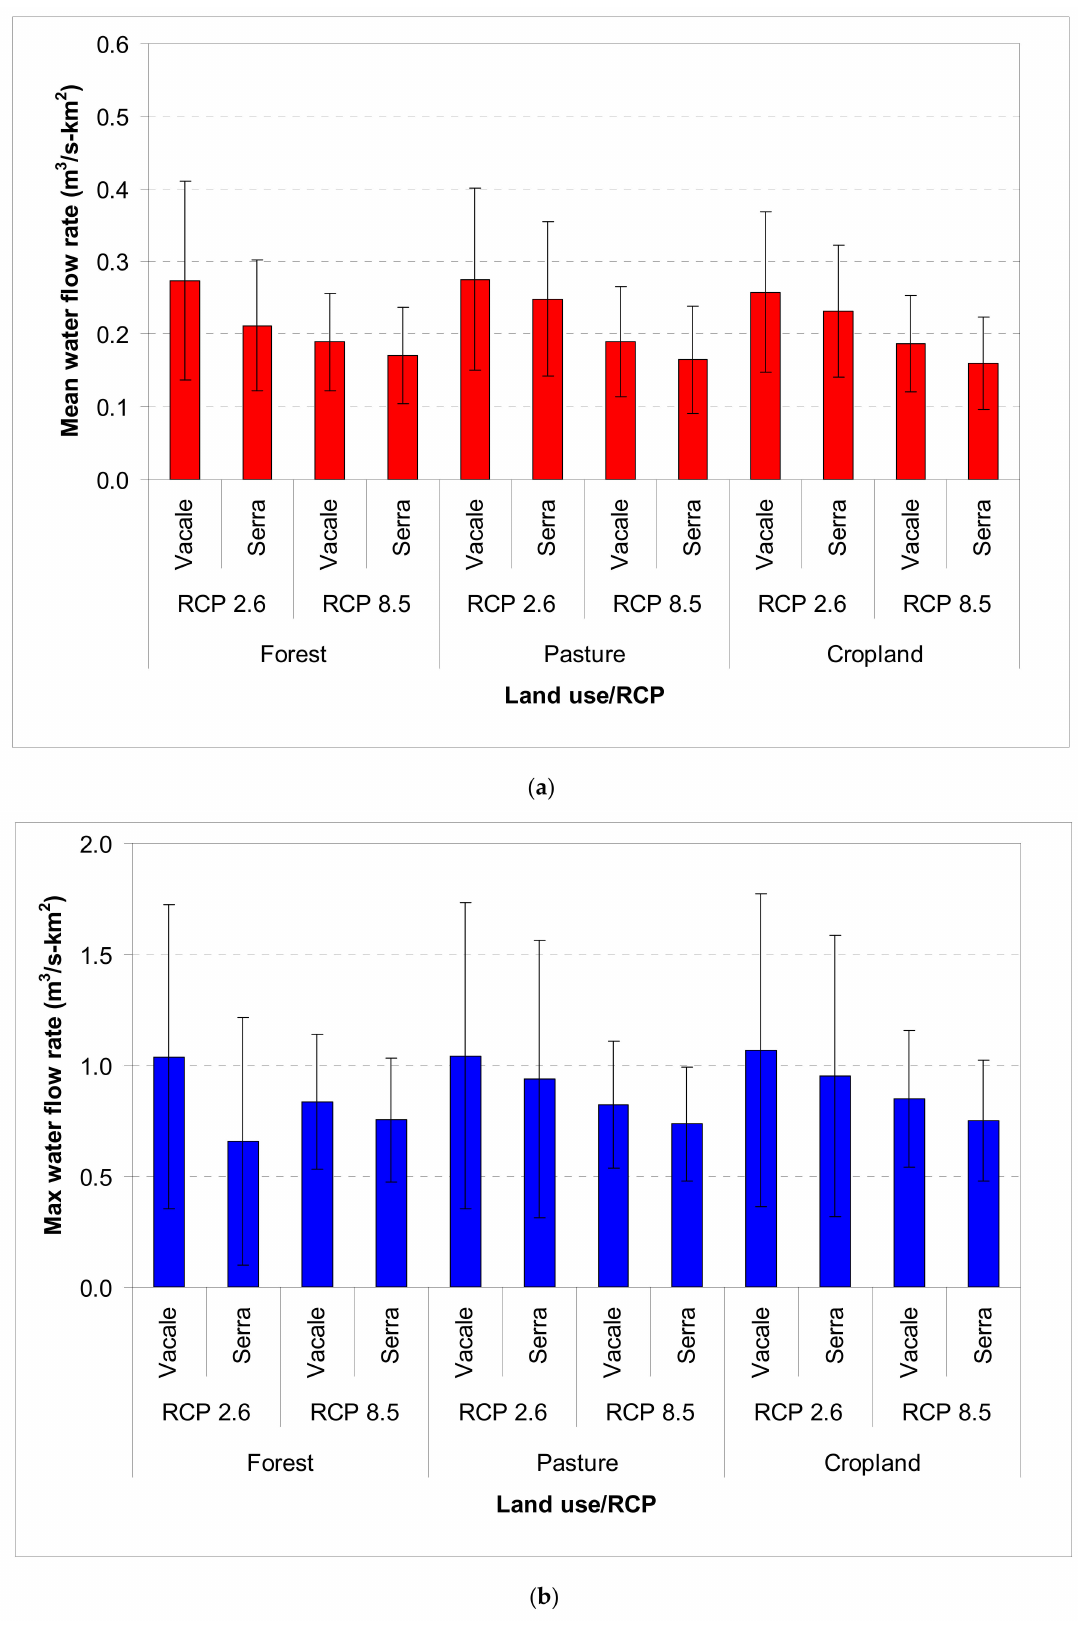
Figure 6. Mean ( a ) and maximum ( b ) values of water flow rate simulated by the SWAT model in unregulated (Serra) and regulated (Vacale) subcatchments (Calabria, Southern Italy). All differences among land use, RCPs, and subcatchments are not significant after Tukey’s test at p <